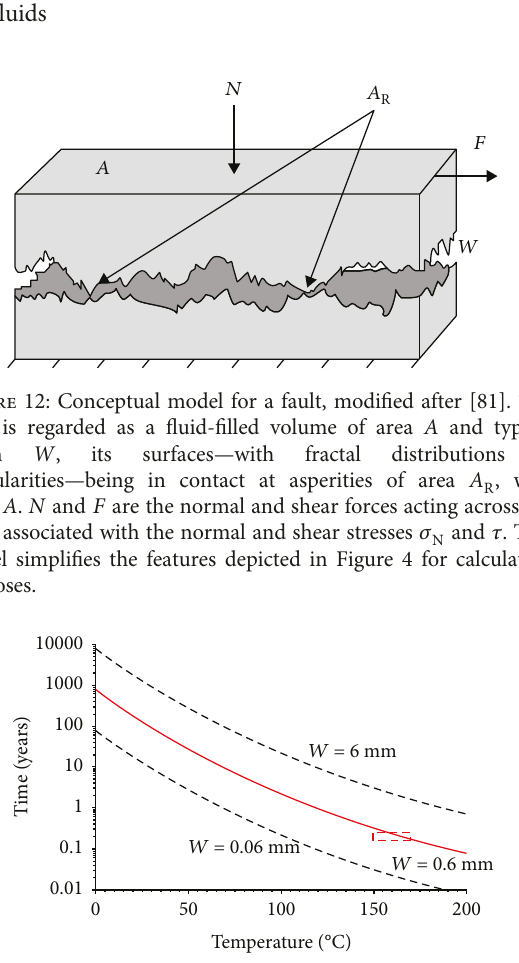
Figure 13: Timescales for equilibration of concentration of dissolved silica (i.e., Si(OH) ) in fractures of width W (where 4 W = 0 06 , 0.6, and 6mm), after Rimstidt and Barnes [68]. concentrations of zero, initially, Calculations assume Si(OH) 4 increasing to 99.3% of the equilibrium value, thus depicting fi ve times the “ time constant ” for the dissolution. Box represents a 160 ± 10 ° C temperature and a 2-3 month timescale, consistent with the bottom-hole temperature and postinjection time-delay observed at Pohang in